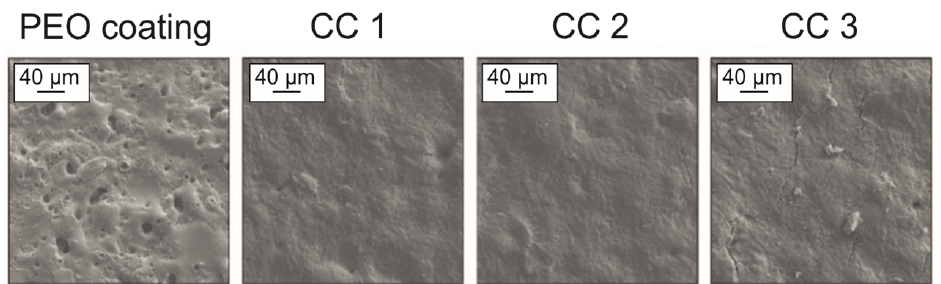
Figure 1. SEM images of the PEO and composite coatings on aluminum alloy. The analysis of the SEM image of the cross-section of PEO coating and CC 3 indicated the incorporation of the polymer into the porous part of the PEO layer, which means that the formed coatings were composite. Additionally, the results of the analysis of the cross-section coatings in Figure 2 made it possible to reveal a decrease in the distribution of pores within the coatings P cs with an increase in the amount of the sprayed substance due to filling mainly the upper porous layer of the PEO coating. The coatings formed on aluminum had a small surface porosity (Figure 1), and due to the peculiarities of the